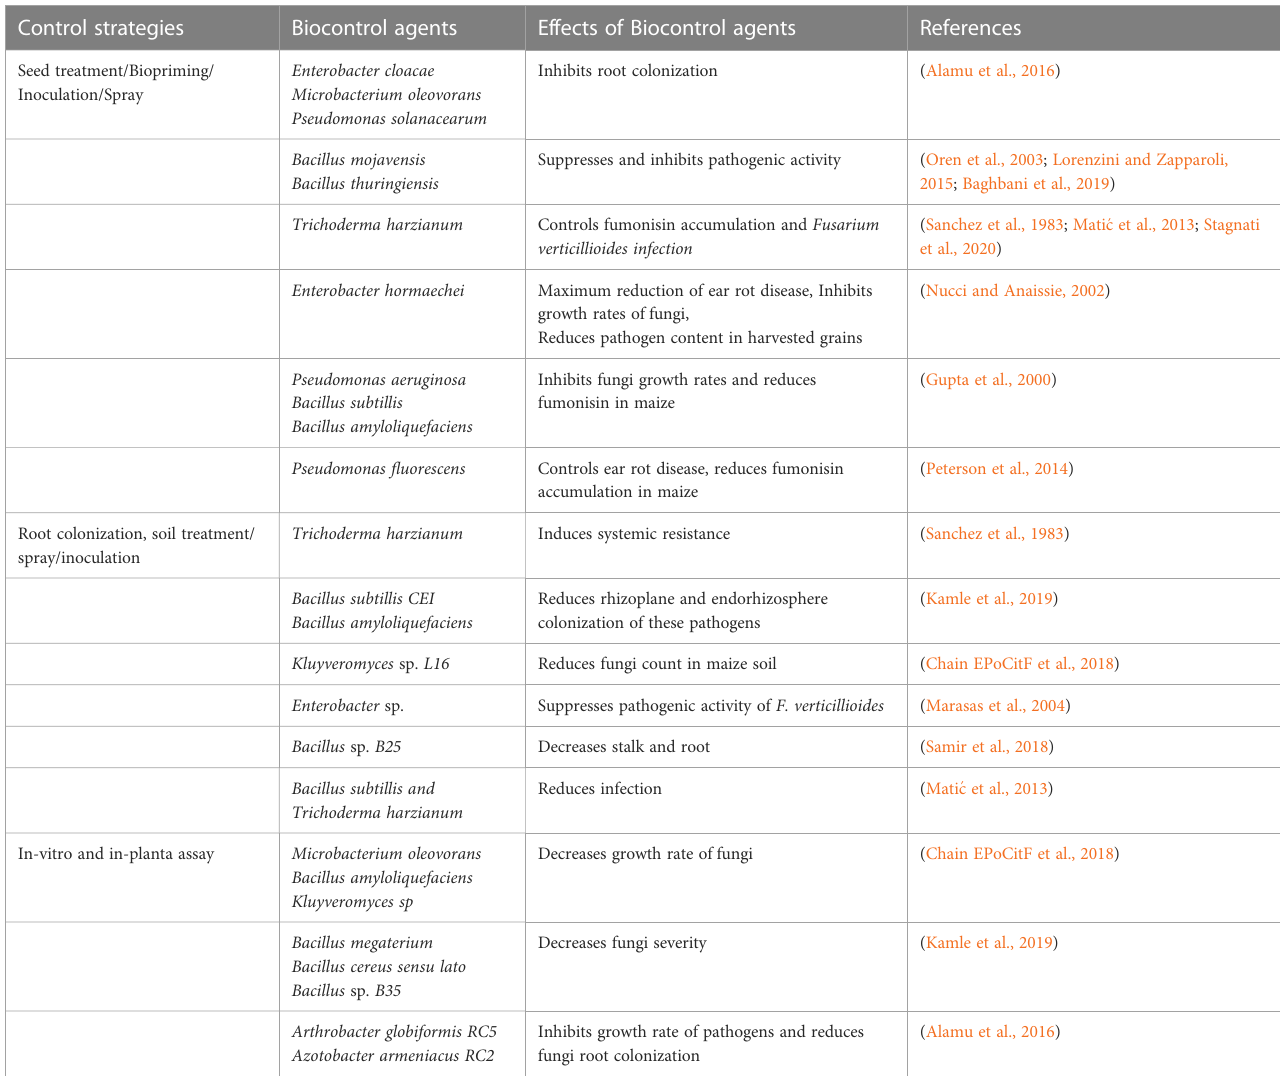
TABLE 2 Other plant associated microorganisms with potentials for Fusarium verticillioides and fumonisin